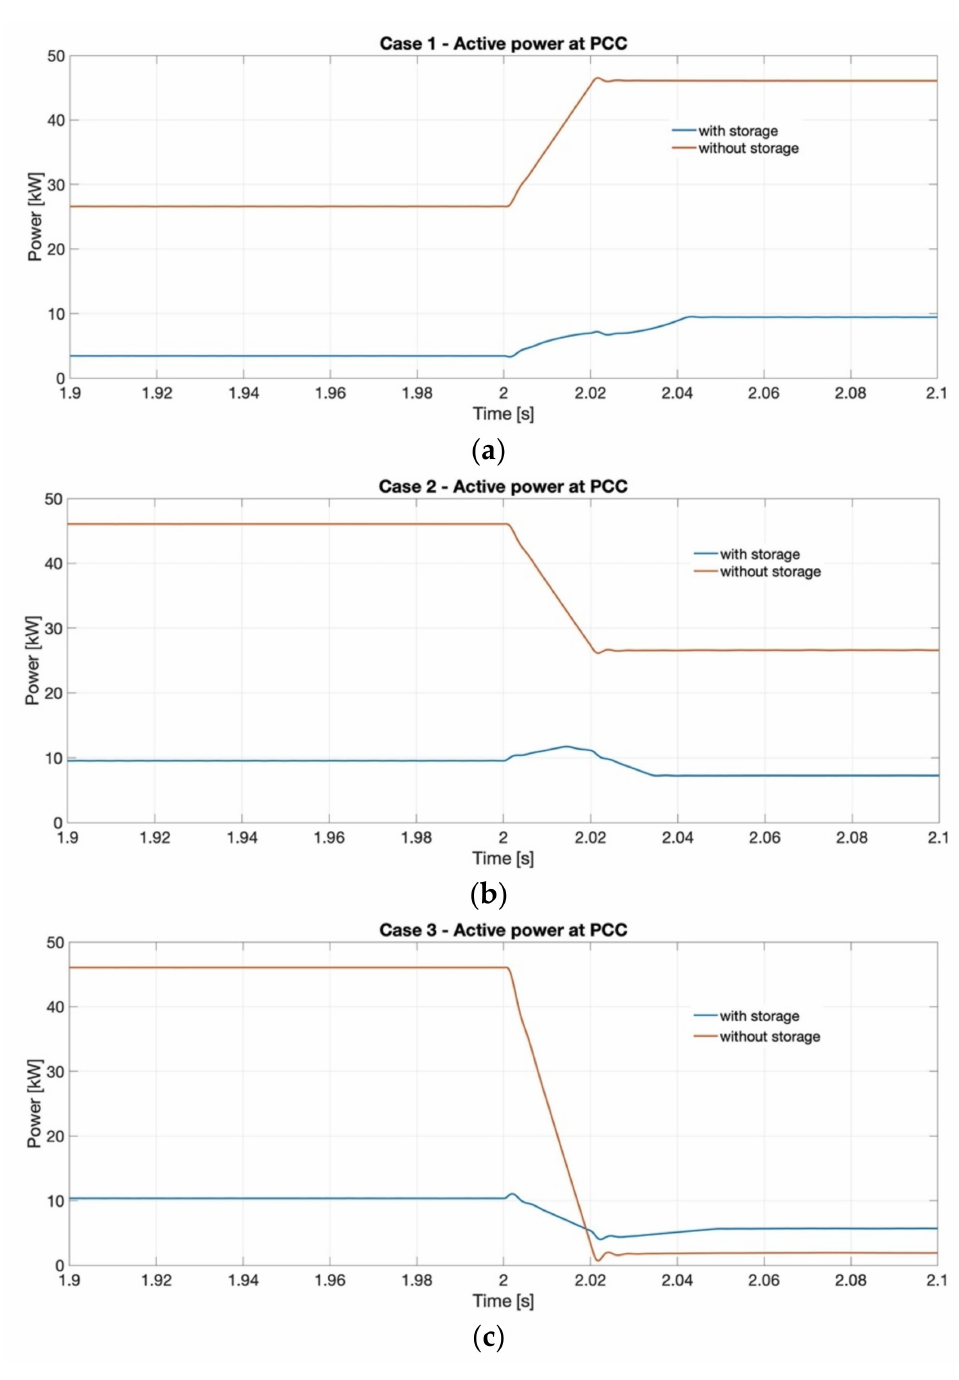
Figure 8. Power exchanges at PCC: ( a ) Case 1, ( b ) Case 2 and ( c ) Case 3. In the following, the behavior at the PCC is analyzed in terms of current and voltage frequency response in the three simulation scenarios. According to Figure 9 (single phase current is depicted, given that the network is considered balanced among the three phases), it is noticeable that the HESS coupling introduces, because of the additional converters, a slightly longer current transient. However, as already mentioned for the power exchanges (Figure 8), the steady state value is reduced, the HESS enabling a smoother response to the sudden change in the wave produced